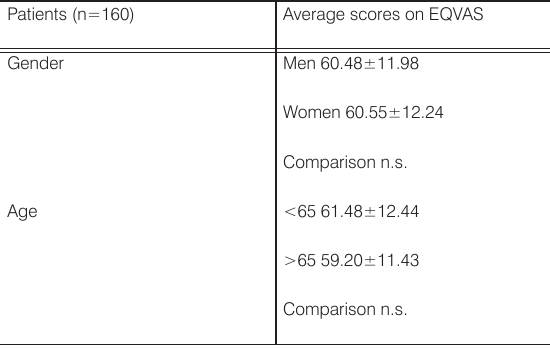
Table 3. The average scores on EQVAS by gender in